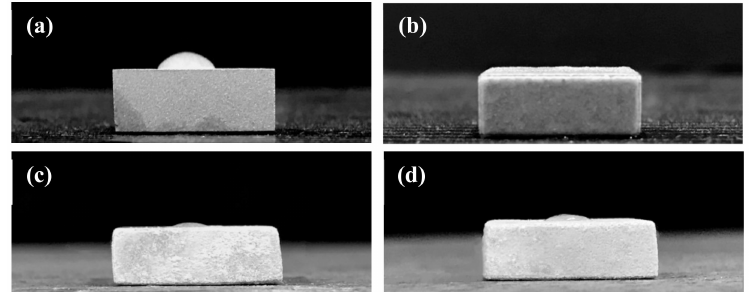
Figure 6. Hydrophilicity of the ( a ) grit-blasted AZ91D Mg alloy, ( b ) alkaline pre-treated AZ91D-AP, hydrothermally synthesized ( c ) HAC and ( d ) Sr-HAC specimens.